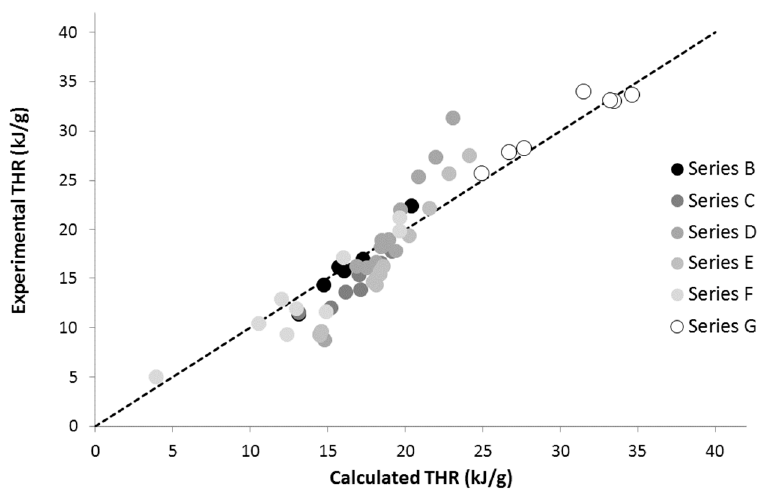
Figure 5. Experimental versus calculated THR for polymers bearing phosphonate pendant groups.